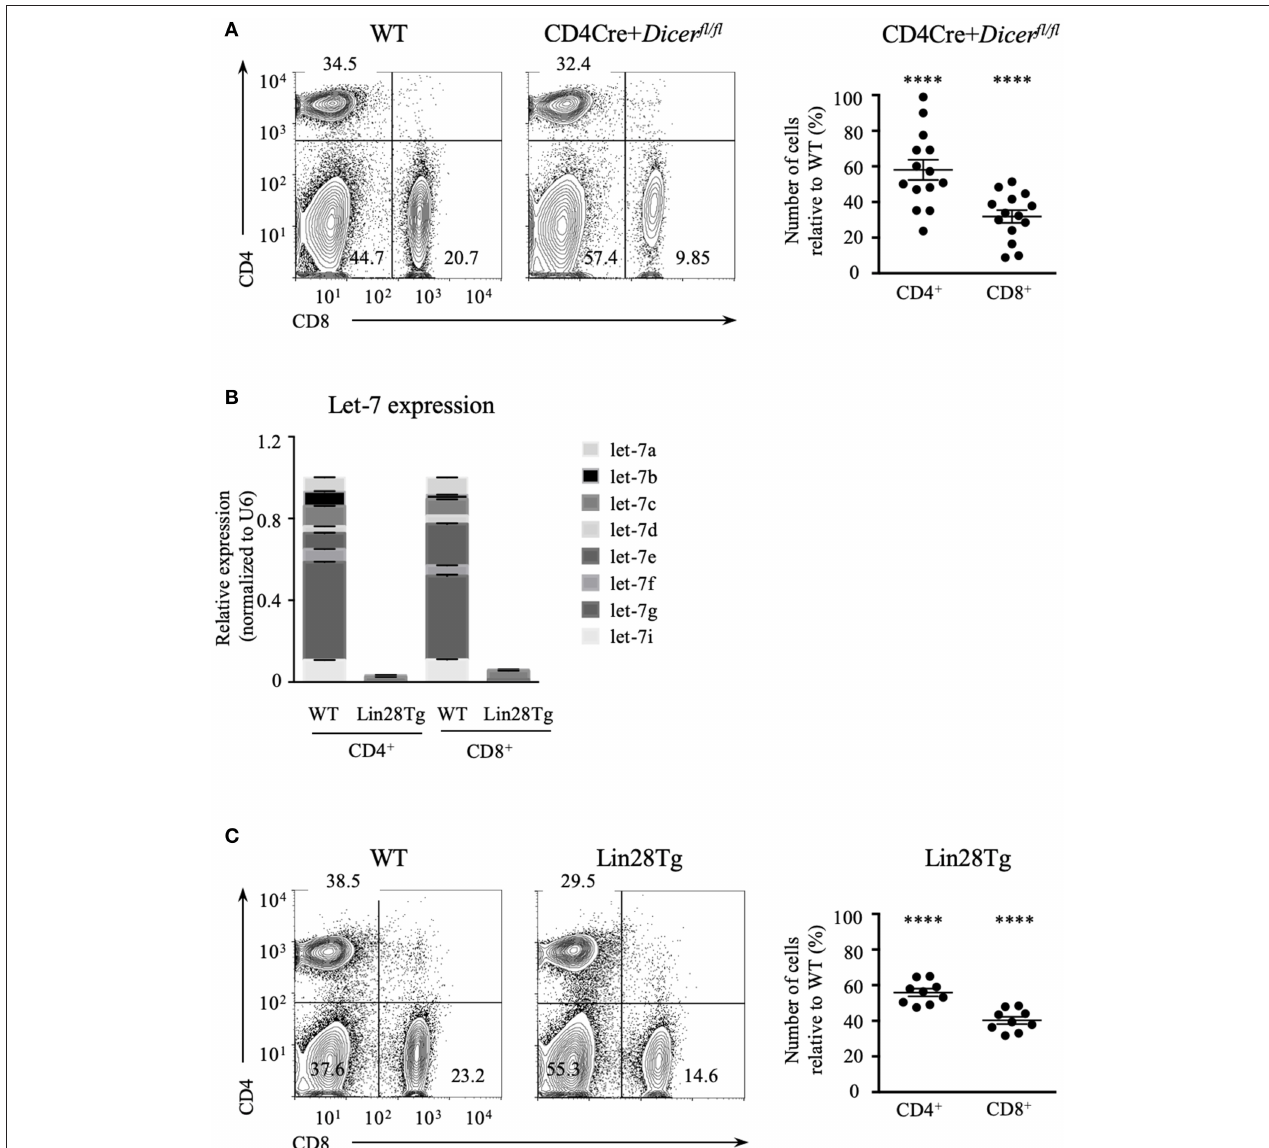
FIGURE 1 | Let-7 is necessary to maintain peripheral T cell numbers and frequency. (A) CD4 and CD8 expression on lymph node cells from wild type and CD4Cre + Dicer fl / fl mice (left). Number of CD4 and CD8 lymph node T cells in CD4Cre + Dicer fl / fl mice normalized to wild type littermate controls (right). (B) Quantitative RT-PCR analysis of individual let-7 miRNAs in CD4 and CD8 lymph node T cells from wild type and Lin28Tg mice. (C) CD4 and CD8 expression on lymph node cells from wild type and Lin28Tg mice (left). Number of CD4 and CD8 lymph node T cells in Lin28Tg mice normalized to wild type littermate controls (right). Data are from at least three independent staining experiments and are displayed as mean ± SEM of each population from 14 (A) and 9 (B) individual mice, **** p <